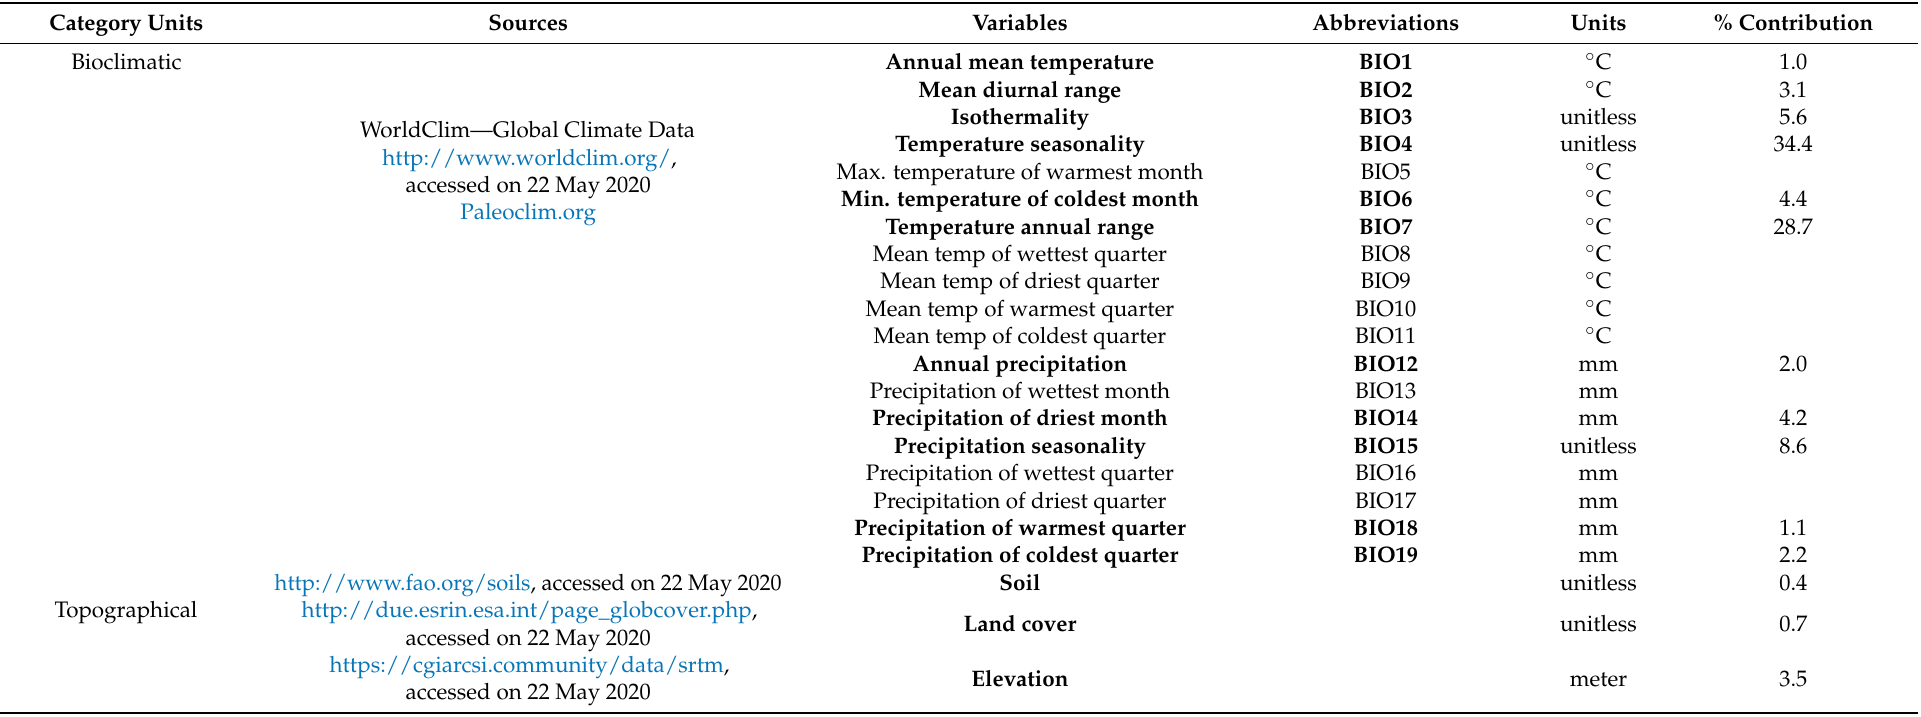
Table 2. Bioclimatic and topographic variables (in bold texts) used for predicting habitat suitability for coconut in India and their contribution to habitat